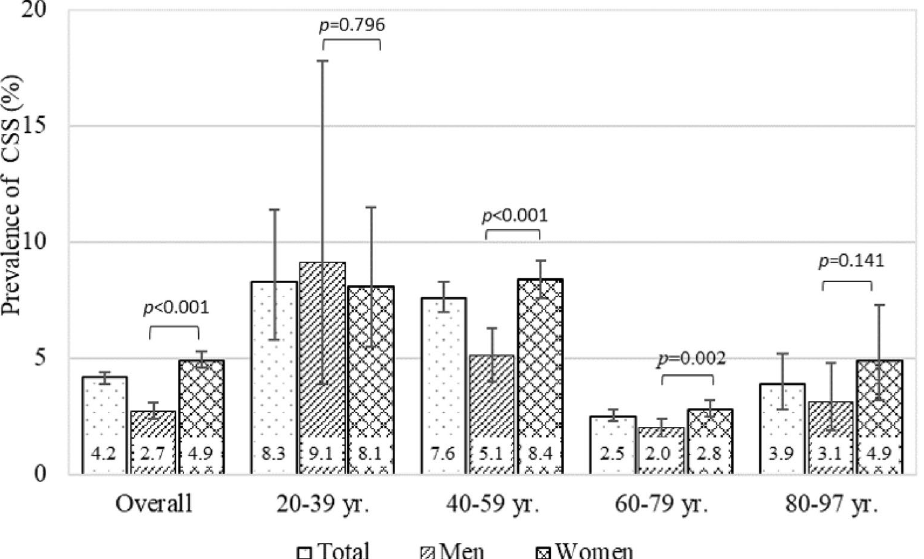
Figure 3. Prevalence of CSS with a CSI-A score ≥ 40 points by sex and age groups. CSS Central sensitization syndromes, CSI Central sensitization inventory. A chi-squared test was performed between men and women. Error bars indicate the 95% confidence interval, which based on total, men, and women are 3.9–4.4, 2.4–3.1, and 4.6–5.3 for overall, 5.8–11.4, 3.9–17.8, and 5.5–11.5 for 20–39 yr., 7.0–8.3, 4.0–6.3, and 17.6–9.2 for 40–59